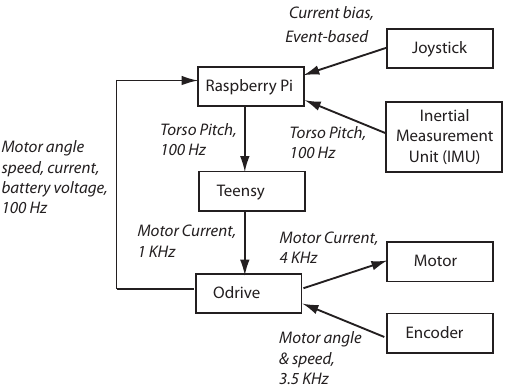
Figure 3. Schematic of the electronics layout: The Raspberry Pi does all the high-level data manage- ment including saving the data and receiving inputs from the Odrive motor controller, the inertial measurement unit, and the joystick. The Teensy does the body pitch control using the body pitch data from the Raspberry Pi. The Odrive regulates the motor current based on the input from the